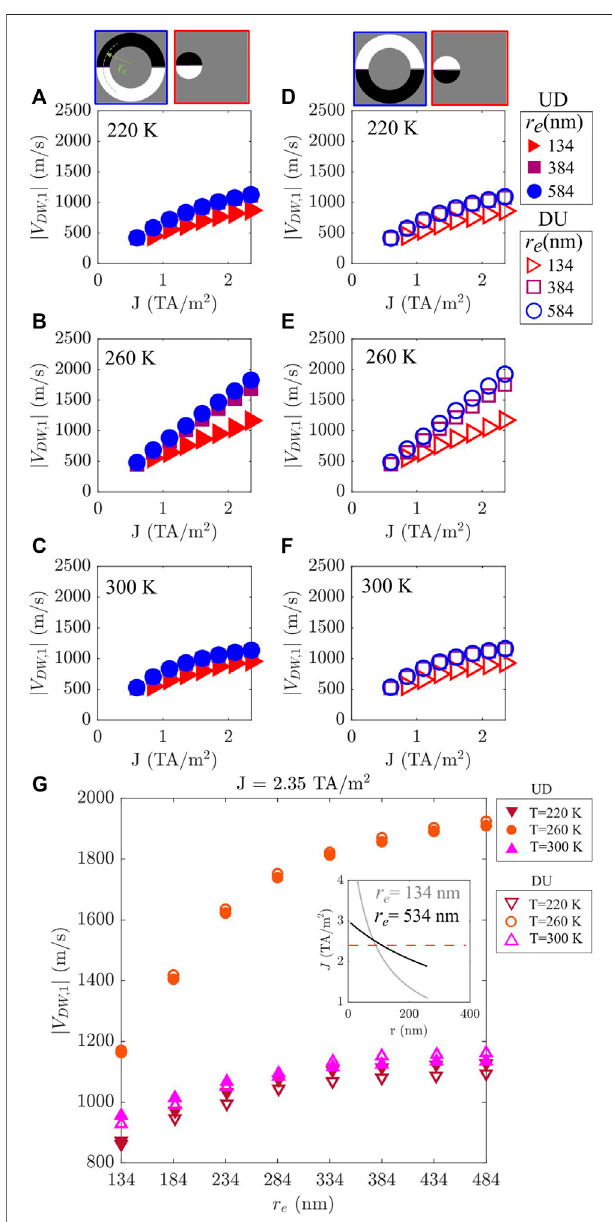
FIGURE5| TerminalvelocitiesasafunctionofJforaUD (A – C) andaDU (D – F) DW in the curved strip obtained for sub-lattice i (cid:2) 1 and for three different temperatures: below, above and at the AMC temperature (220, 300, and 260 K, respectively). Strips for the two limiting cases are shown in the red and blue contourinsets at the top. (G) Terminal velocitiesasafunction of r e for a UD (full symbols) and aDU (open symbols) type wall for J (cid:2) 2.35 TA/ m 2 andthethreechosentemperatures.Insetin (G) shows J ( r )fortwovaluesof r e . Red dashed line indicates J (cid:2) 2.35 TA/m 2 .